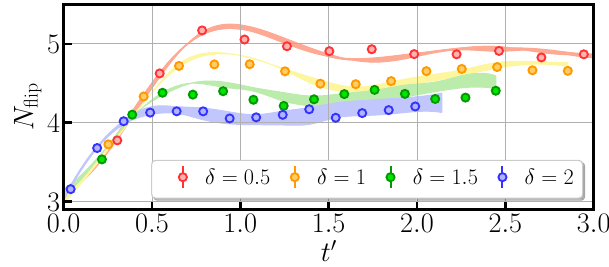
FIG. 4. The dynamics of the number of spin flips (PBCs). The evolution of N flip for δ = 0.5, 1, 1.5, and 2 as a function of the normalized time t (cid:12) . The shaded regions show the results of the simulation using H driven , including the 6 ± 1% fluctuations on the microwave rotation axis (see Appendix